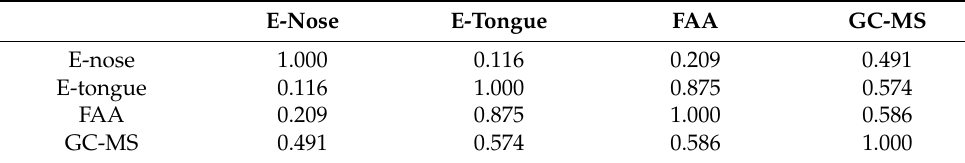
Table 3. RV coefficients of E-nose, E-tongue, FAA, and GC-MS.